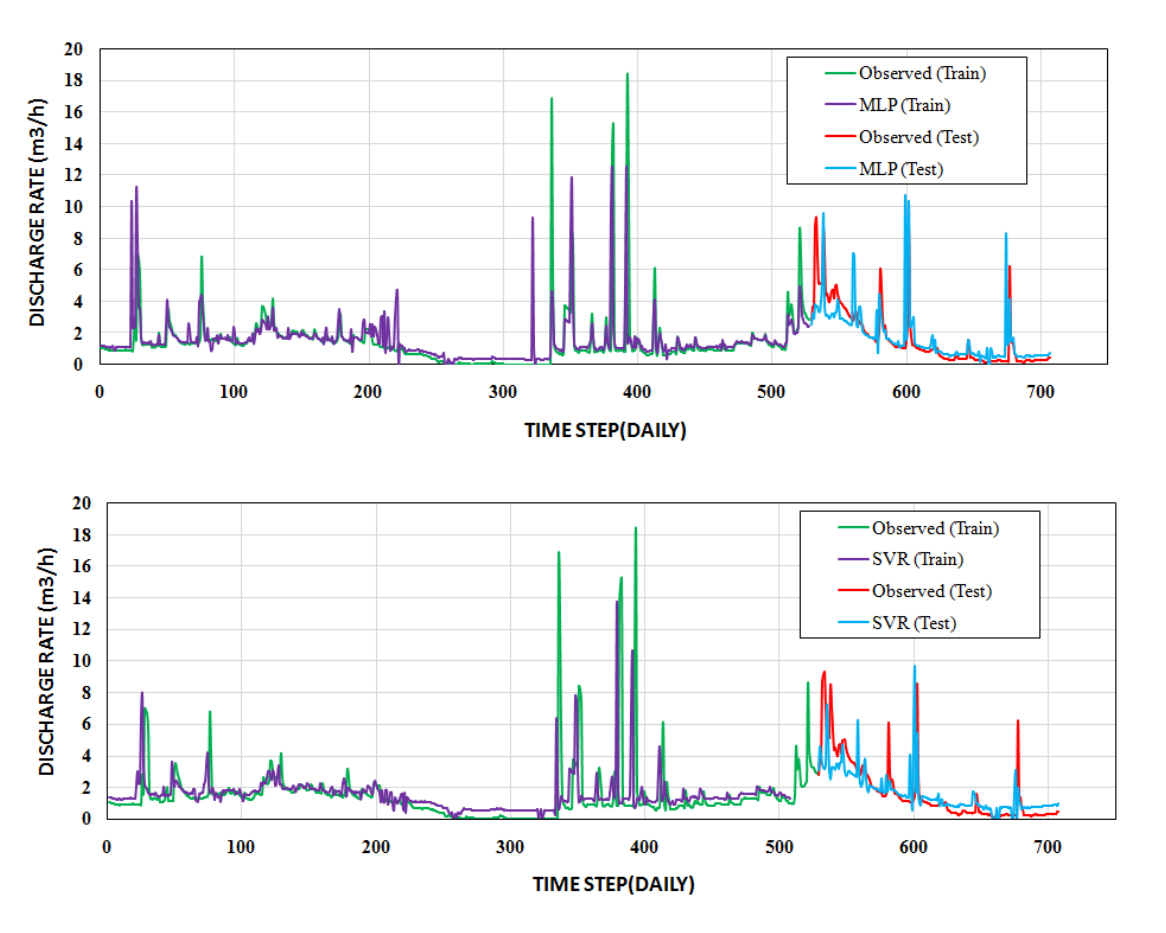
Figure 3: The simulated time series of the flow by models of MLP and SVR according to CMORPH satellite data verification severe sudden changes are observed in the graph, which is Figure 4 shows the time series simulated using data of PERSIANN satellite. probably due to wrong estimation by PERSIANN algorithm. These sudden According to the figure, at the beginning of period of authenticity changes are more visible in the MLP model than